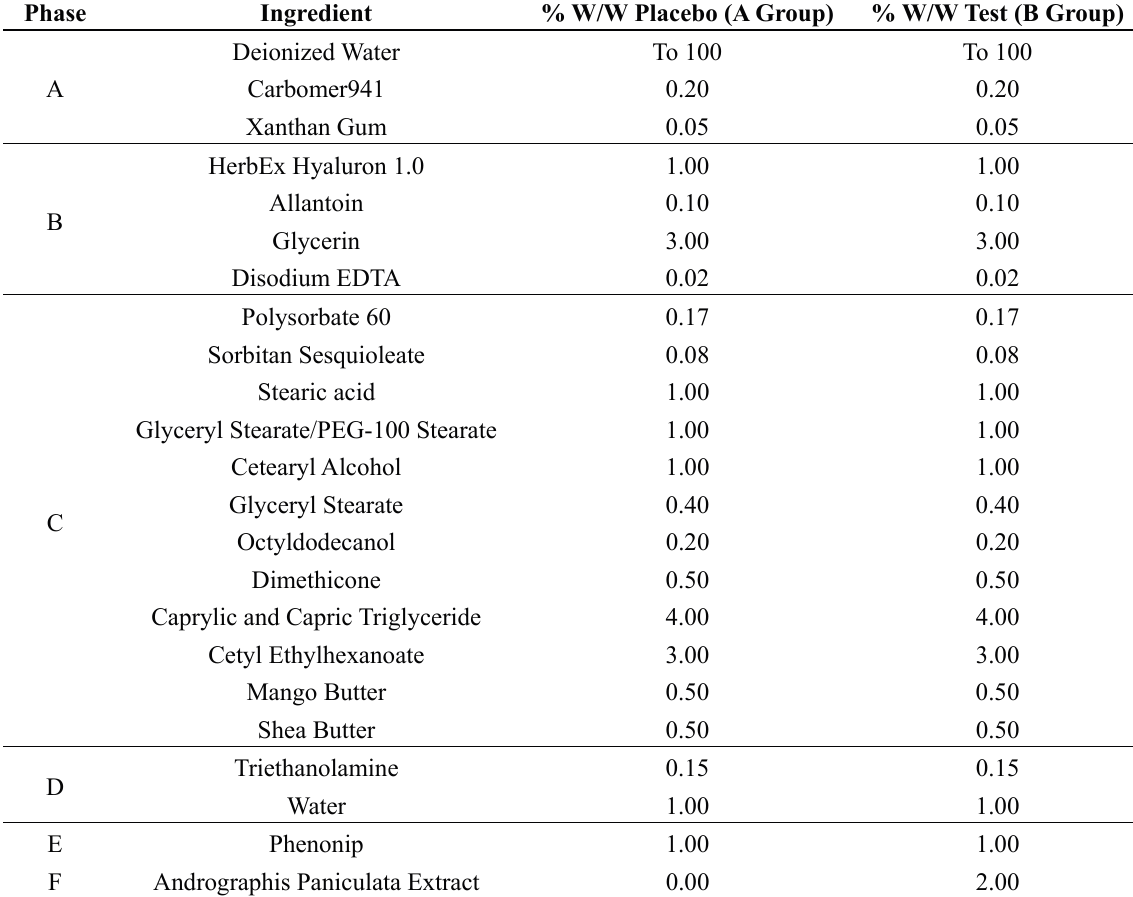
Table 1. Formulation of APE containing cream and placebo